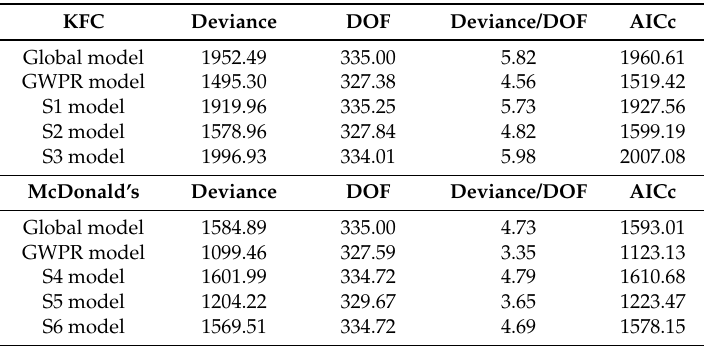
Table 3. Analysis of deviance in